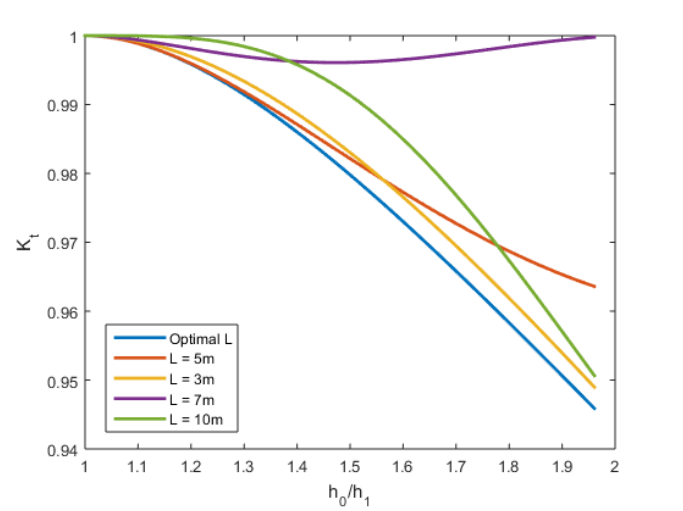
Figure 10. A comparison of K t for values of L , which varies with h 0 = 10 m and w = π